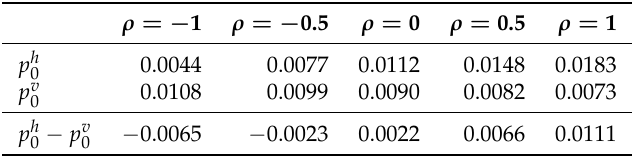
Table 5. Prices of the options giving the right to exchange the “Typical insurer” asset portfolio (as defined in Table 4) for the horizontal (resp. vertical)